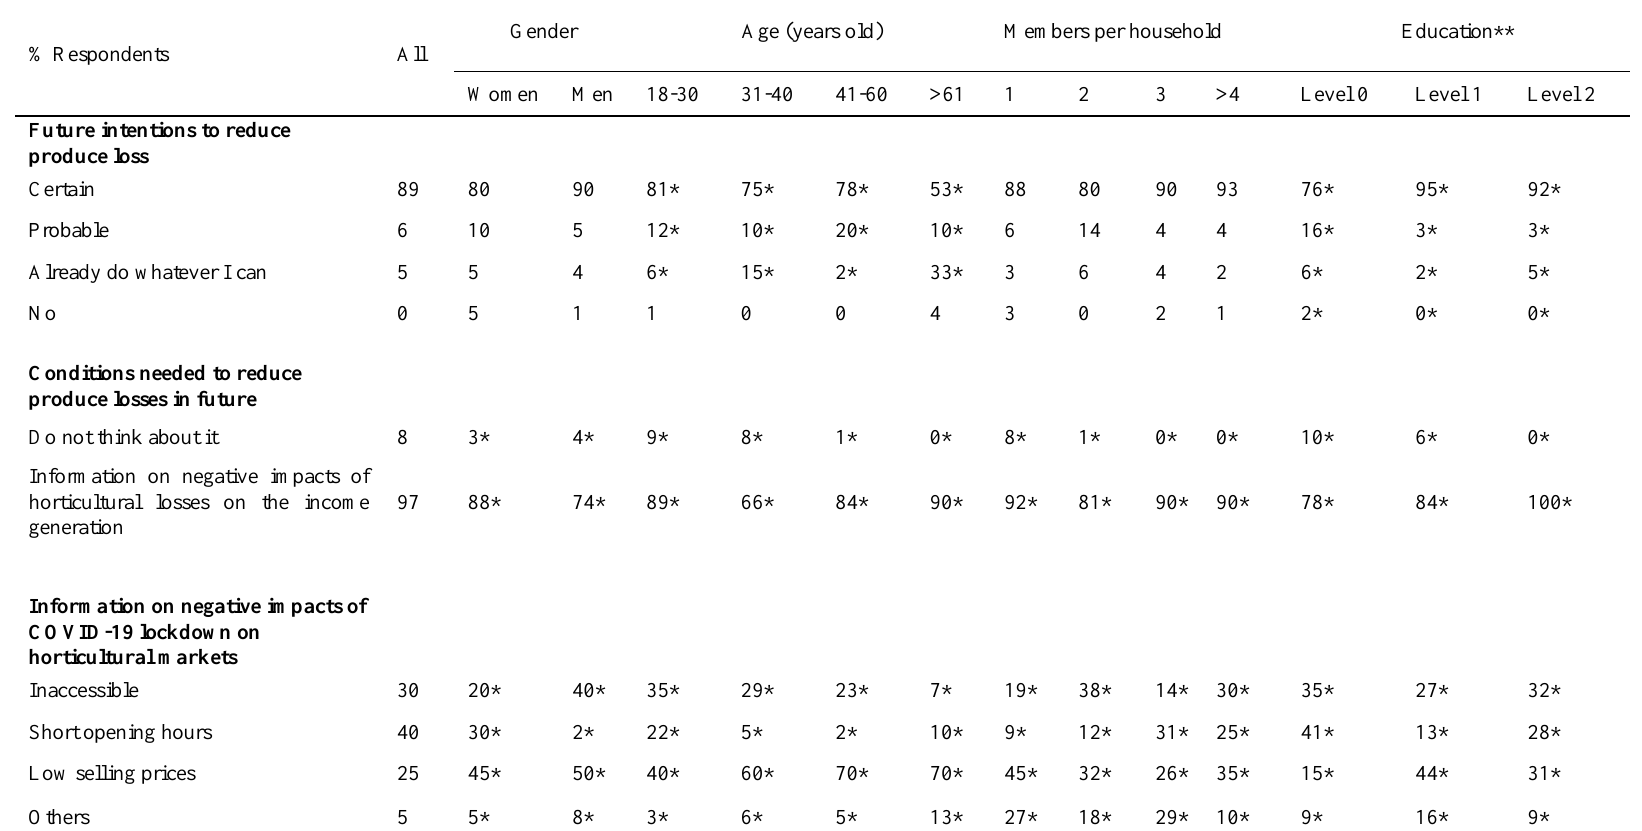
Table 5. The percentage of the respondent of horticulture farmers’ intentional behavior towards minimizing produce loss